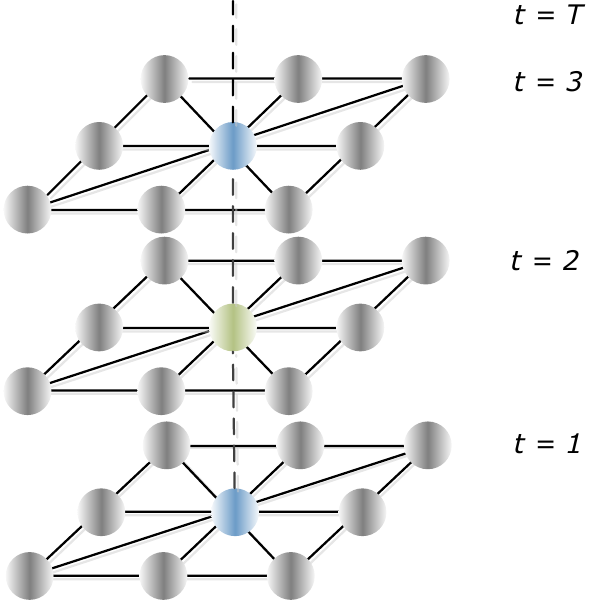
Figure 1. First order temporal neighbours of a node at different times t of a sequence T . Spatial and temporal edges are indicated by solid and dashed lines